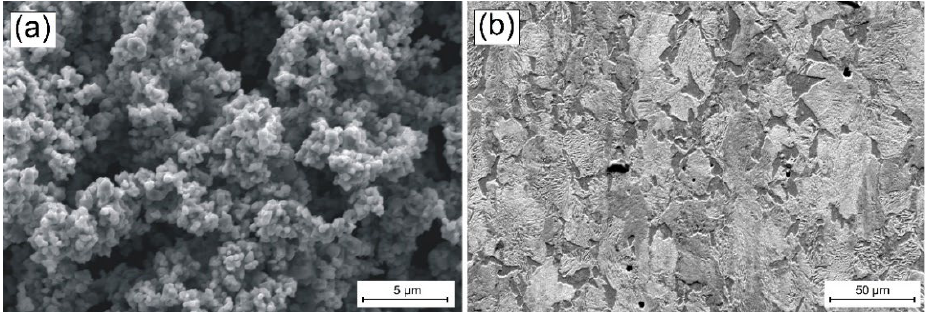
Figure 1. Materials used: ( a ) morphology of vanadium carbide powder particles and ( b ) steel substrate microstructure.